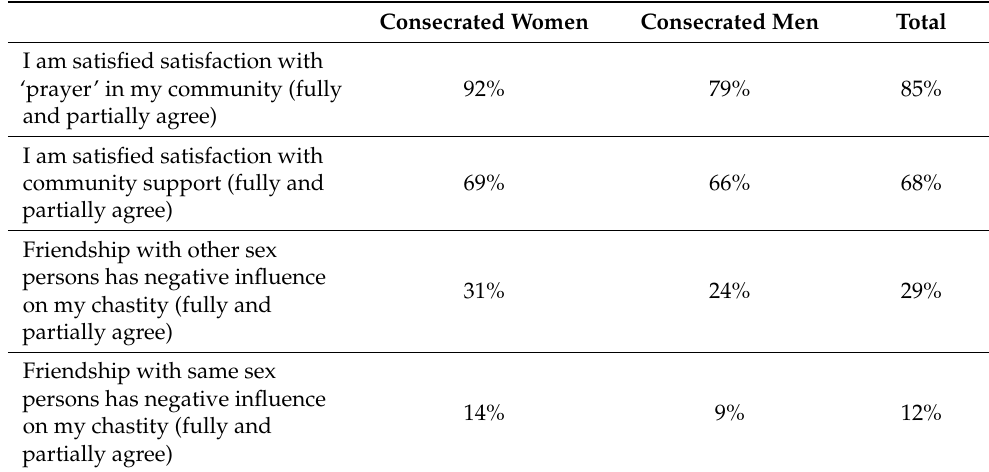
Table 4. Responds for the selected questions. N =